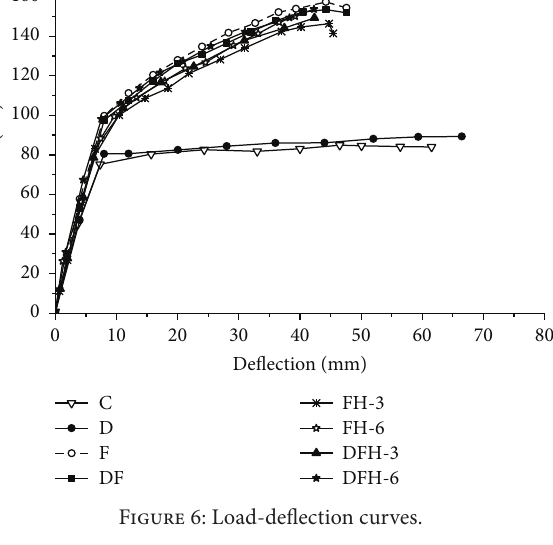
Figure 6: Load-deflection curves.